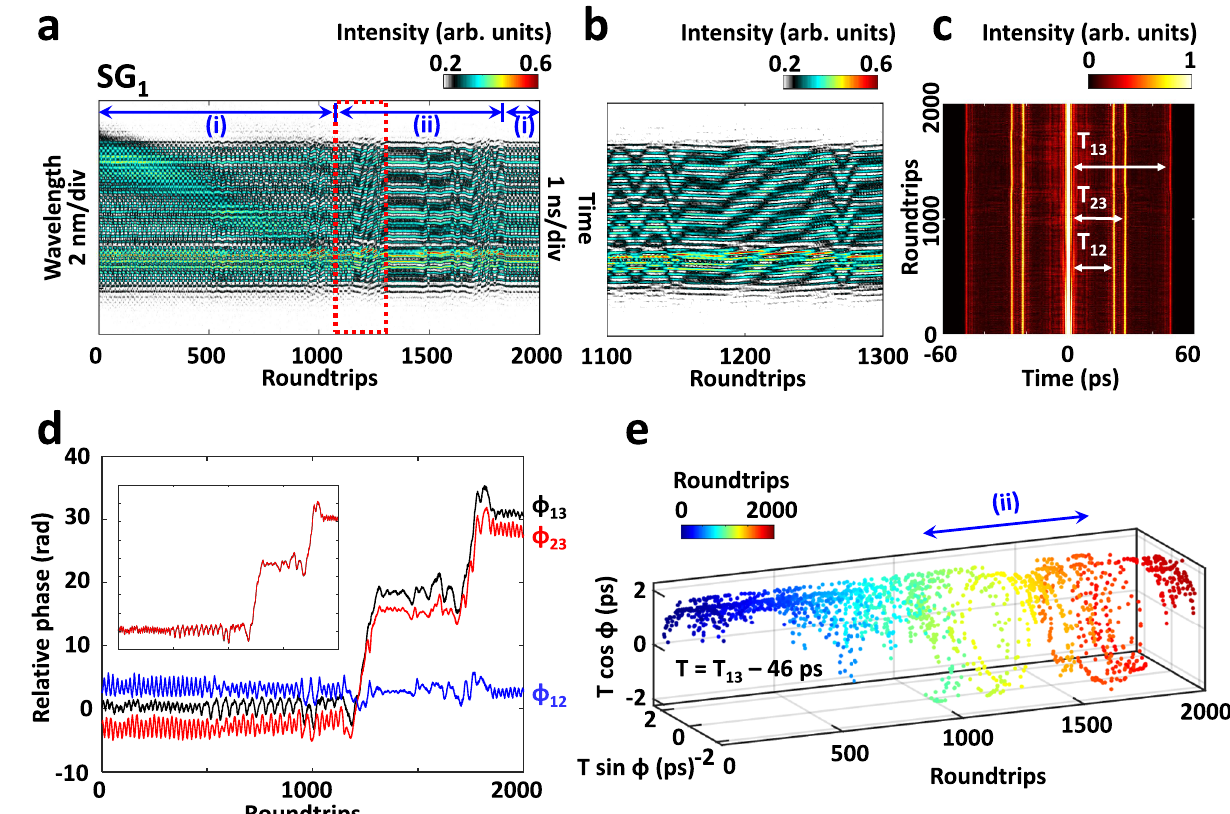
Fig. 6 | Spectral-temporal dynamics of 3D triple-soliton molecules with unequaltemporalspacing.a Spectralevolution of the 3Dtriple-soliton molecule. b Close-up of the spectral evolution, as indicated by the red dotted square in ( a ). c Corresponding FAC evolution of ( a ). d Relative phase variations of the FAC